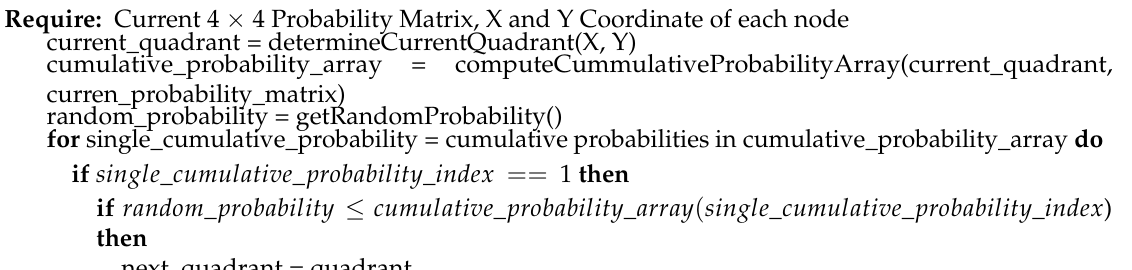
Algorithm 3 Move node position utilizing the probability